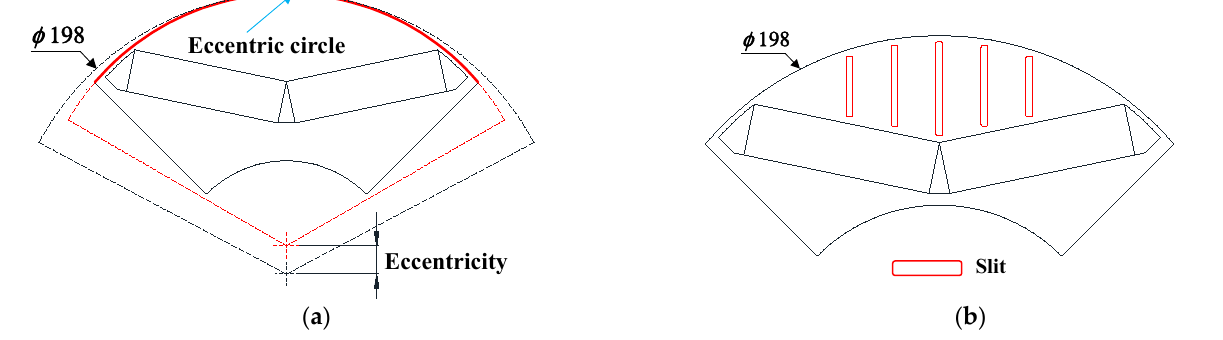
Figure 4. Induced EMF at no-load drive for the initial design: ( a ) wave form, and ( b ) harmonic order.